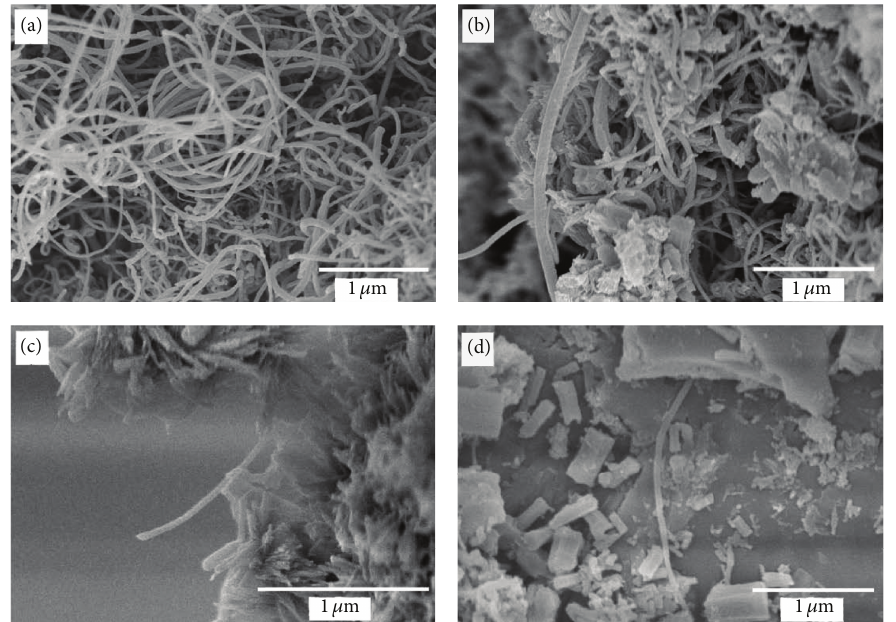
Figure 4: Surfactant concentration effect on CNTs dispersion: (a)–(d) represent a dispersant to MWCNT weight ratio of 0, 1.5, 4.0, and 6.25, respectively [72].